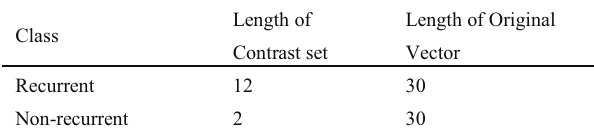
Table 5. Lengths of the discovered contrast sets of the Breast Cancer Wisconsin (Prognostic) dataset.